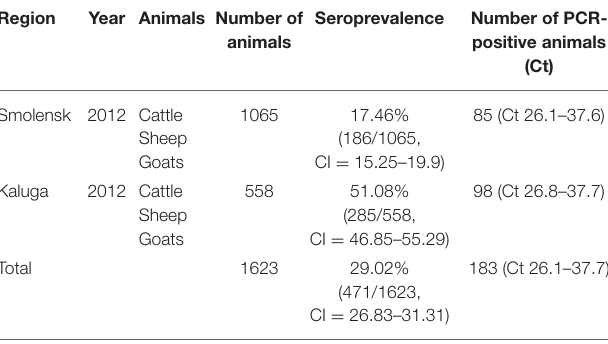
TABLE 2 | Serological and virological investigation of local animals in the Smolensk and Kaluga regions during 2011–2012.